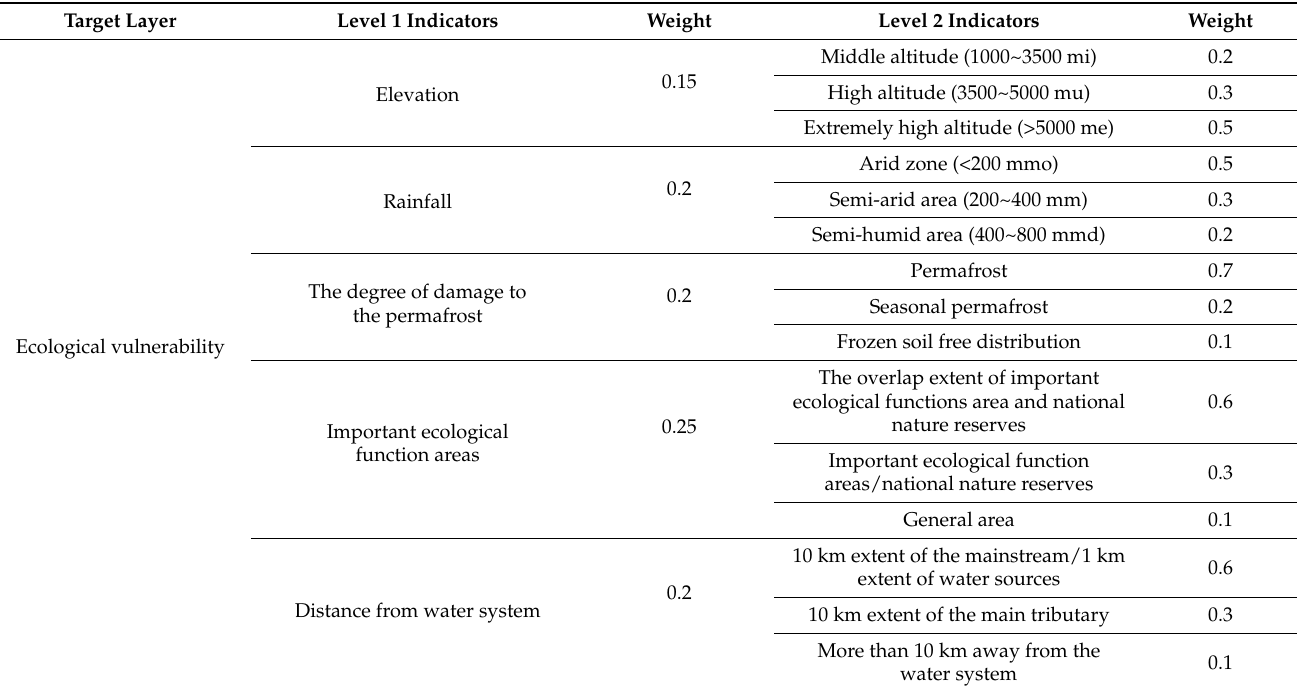
Table 3. Table of ecological vulnerability assessment index